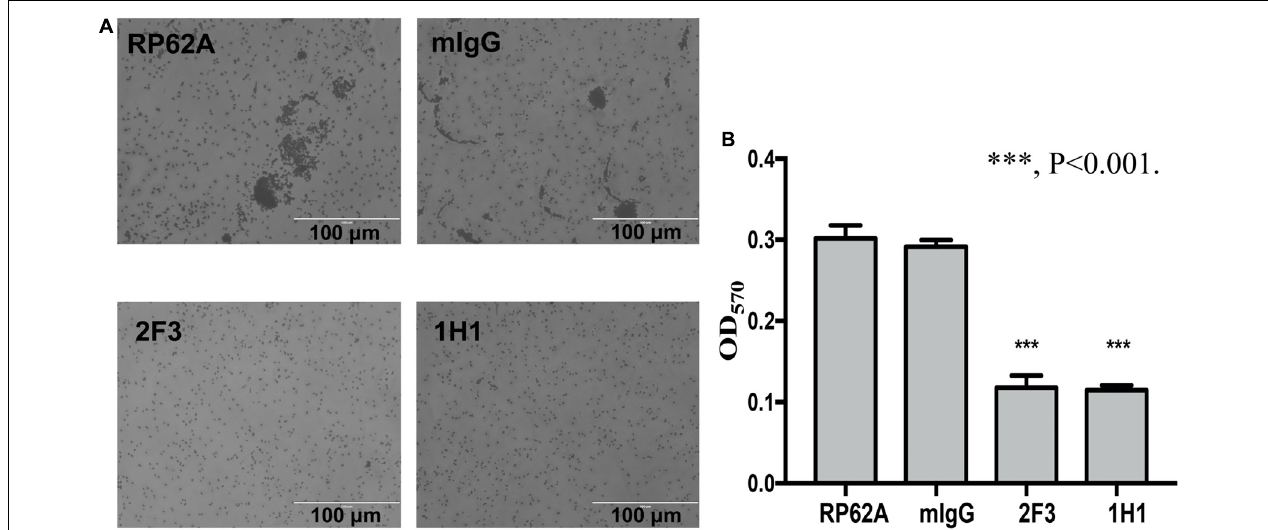
FIGURE 2 | Effect of YycG ex mAbs on initial attachment of S. epidermidis RP62A. Bacterial cells were diluted in TSB containing 160 µ g/mL YycG ex mAbs and incubated at 37 ◦ C with shaking at 220 rpm for 6 h. (A) Adherence ability visualized microscopically. (B) Cell attachment measured as OD 570 after crystal violet staining. Experiments were performed using three replicates and repeated thrice independently. RP62A: untreated; mIgG: normal mouse IgG treated. Statistical analyses were performed using Student’s t -test. ∗∗∗ P < 0.001.